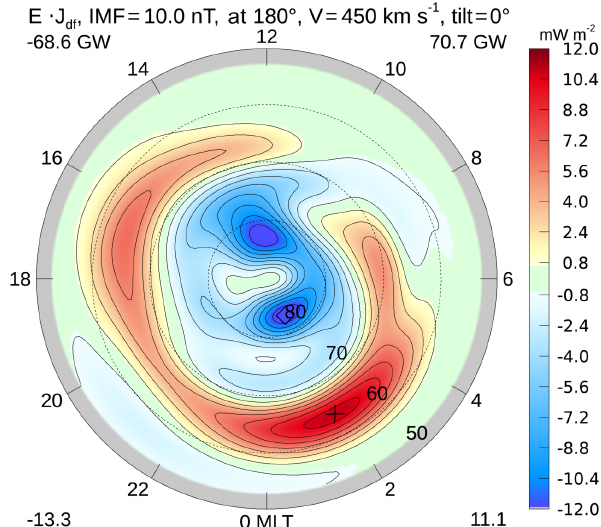
Figure 10. Dot product of electric field and divergence-free cur- rent, for the same conditions as in Fig. 1. The IMF B T magnitude is 10nT at 180 ◦ , the solar wind velocity is 450km s − 1 , the F 10 . 7 index is 160sfu, and the dipole tilt angle is 0 ◦ . The integrated sum of all negative values is indicated in the upper left corner, and this total for all positive values is indicated in the upper right corner, in units of